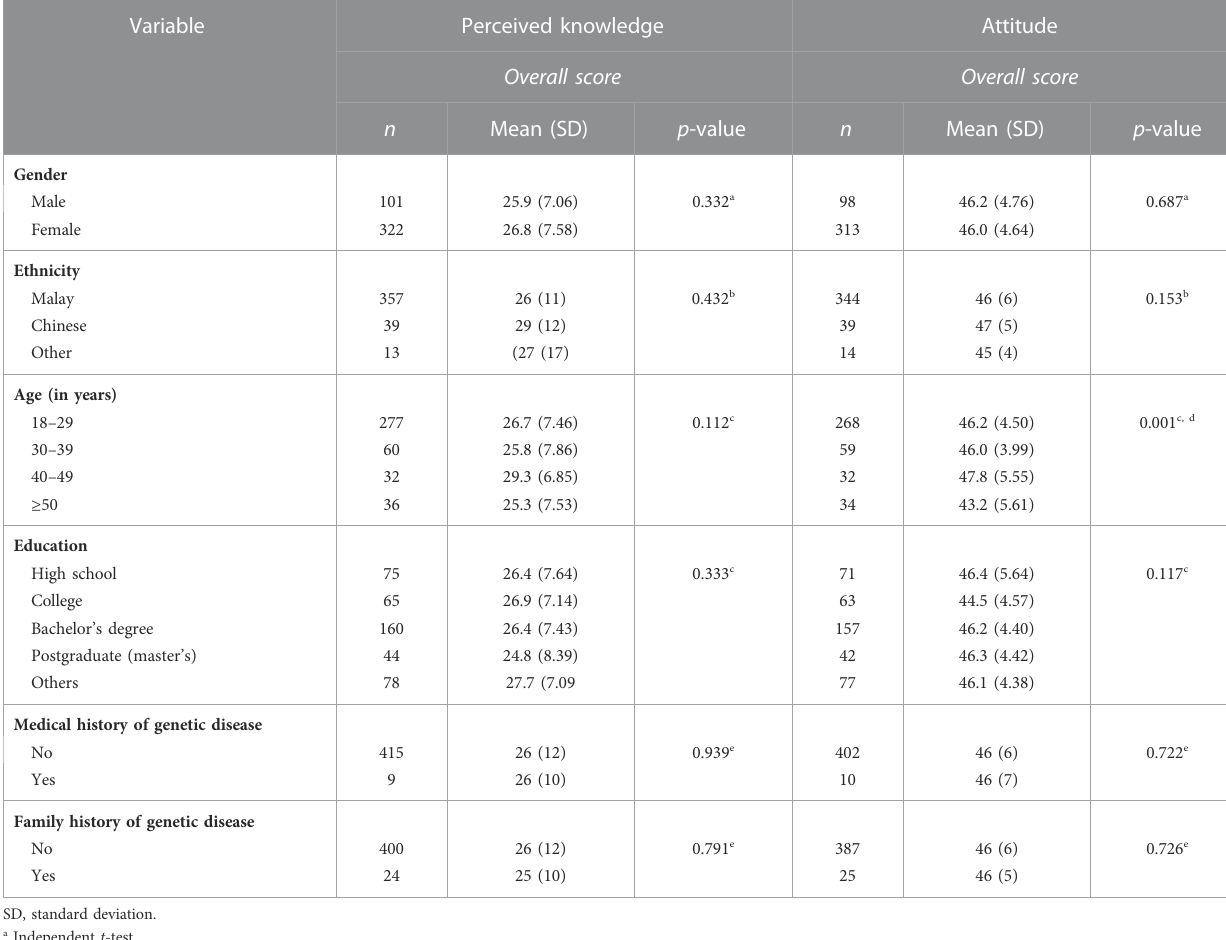
TABLE 6 p -value for the respective variables pertaining to questions on perceived knowledge of genetics and attitude toward genetic